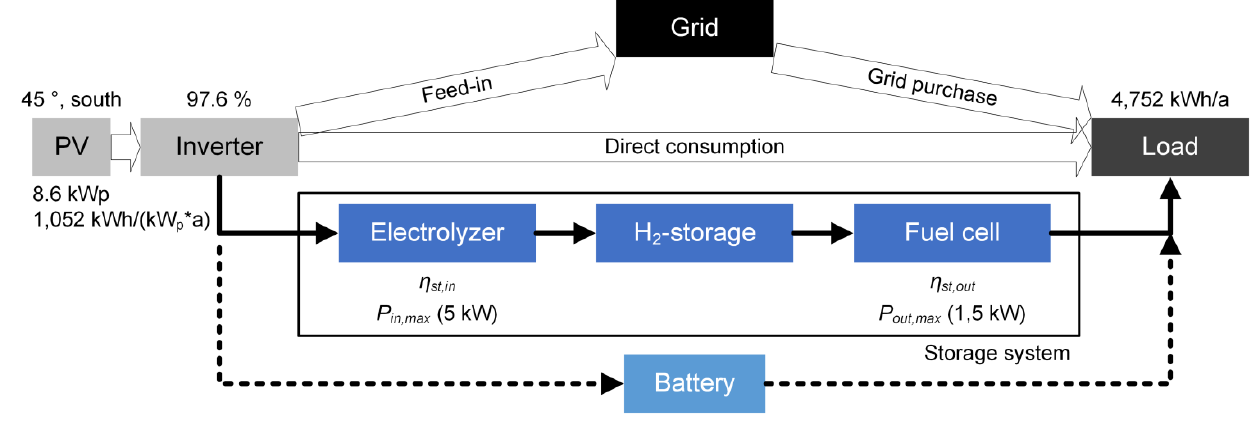
Figure 1. Block diagram of the considered energy